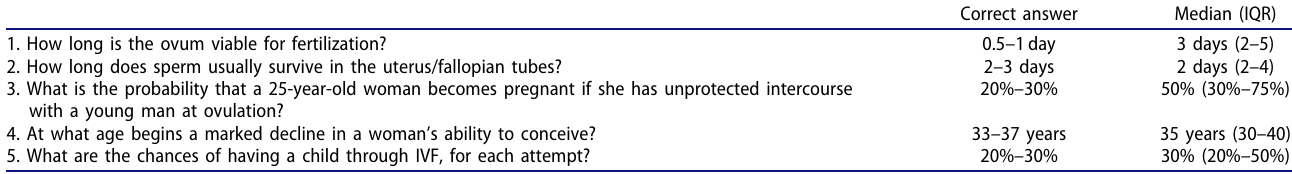
Table 4. Fathers ’ fertility knowledge. Median and interquartile range (IQR, 25th – 75th percentile). Answers from five questions on fertility.